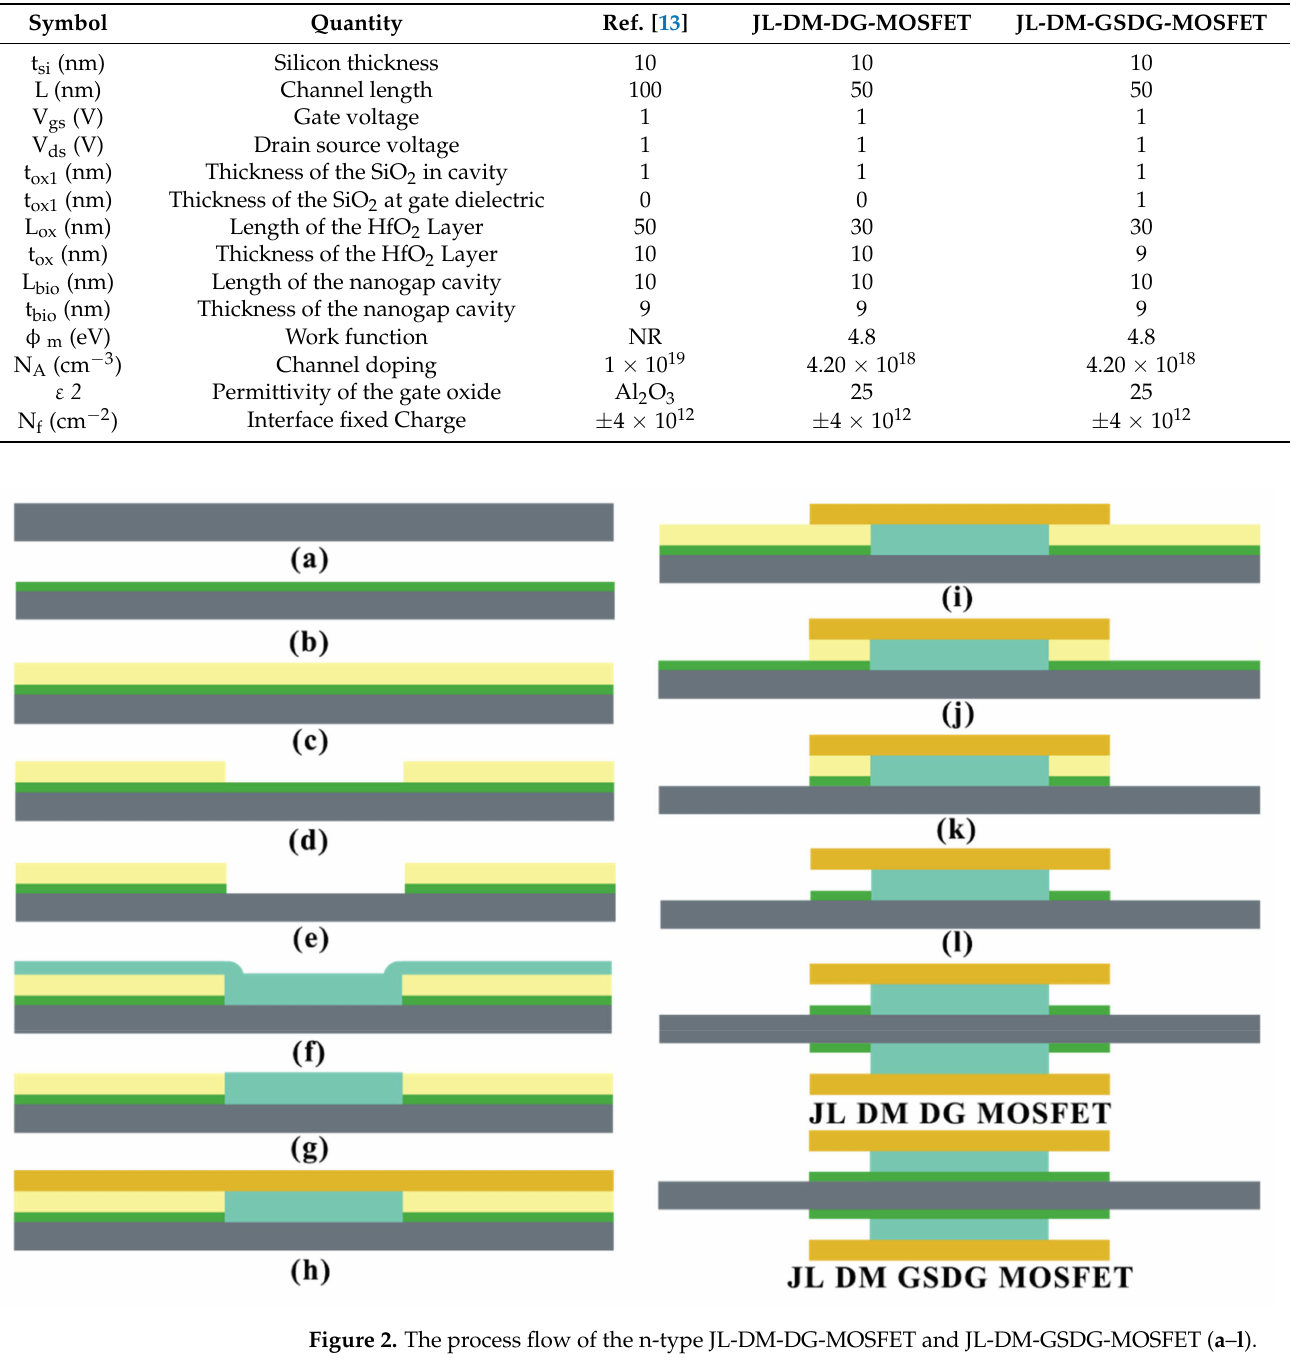
Table 1. Device Design parameters of JL-DM-DG-MOSFET and JL-DM-GSDG-MOSFET.